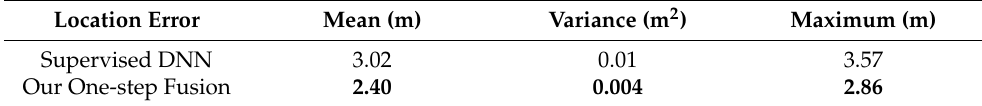
Figure 15. Location error curves when GNSS is denied in Scenario 2.